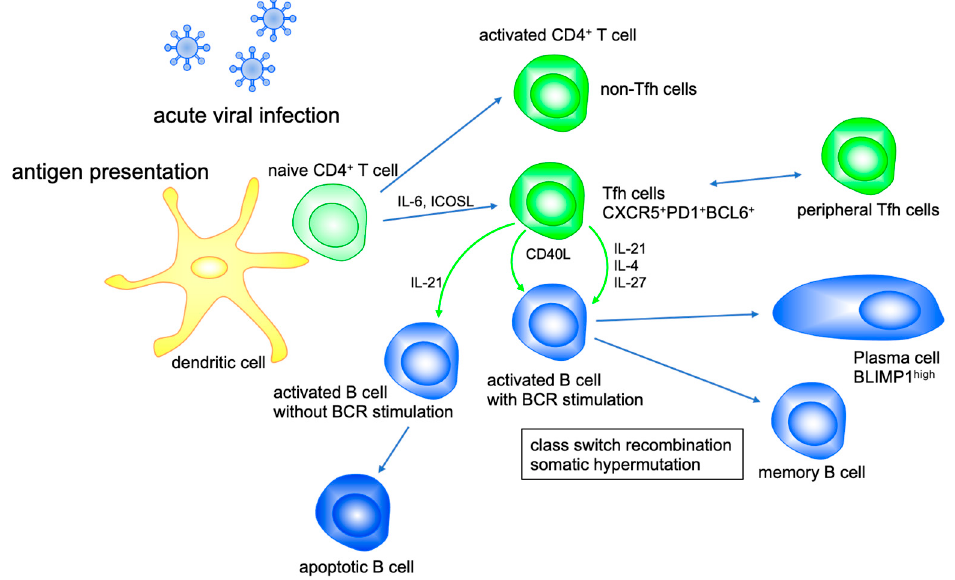
Figure 1. IL-21 modulates B cell function. Tfh cell activates B cell differentiation with CD40L, IL-21, IL-4 and IL-27. IL-21 promotes class switch recombination to IgG1 and IgG3 and suppresses that to IgE. IL-21 enhances somatic hypermutation and production of high-affinity antibodies by plasma cells, whereas IL-21 induces apoptosis of bystander B cells activated without antigen receptor stimulation.